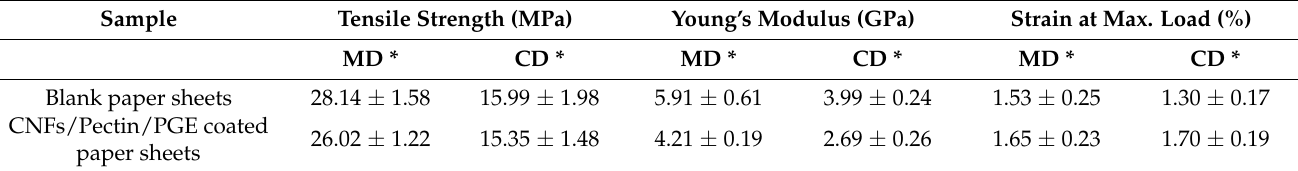
Table 8. Tensile strength properties of blank and paper sheets coated with CNFs/20% Pectin/PGE mixture.